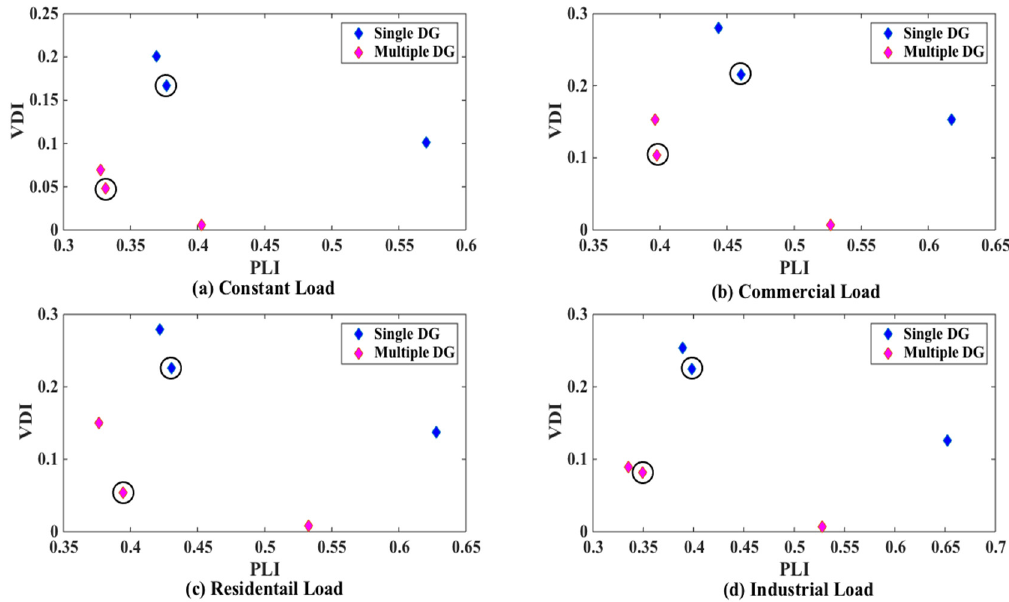
Figure 5. Variation of PLI with variation in VDI for placement single and multiple DGs. ( a ) constant load; ( b ) commercial load; ( c ) residential load; ( d ) industrial load.